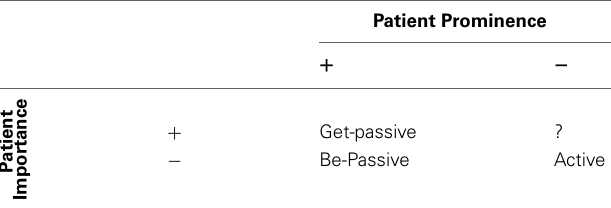
Table 11 | Distribution of the three types of transitive description (active-voice, be-passive, get-passive) along two dimensions (Patient Importance and Patient